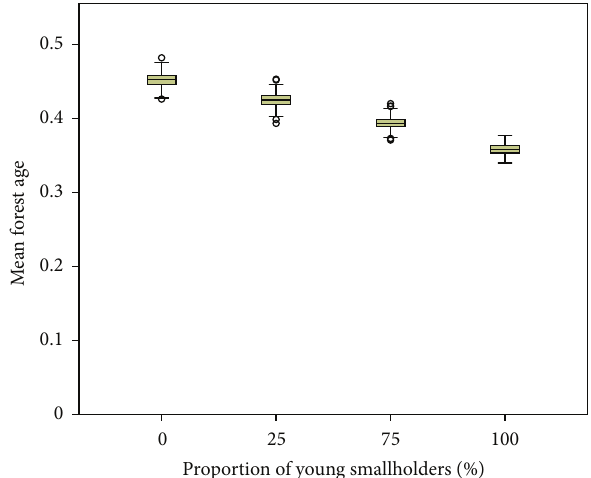
Figure 1: Mean forest age (at the landscape scale) increases signifi- cantly as the proportion of young smallholders decreases.